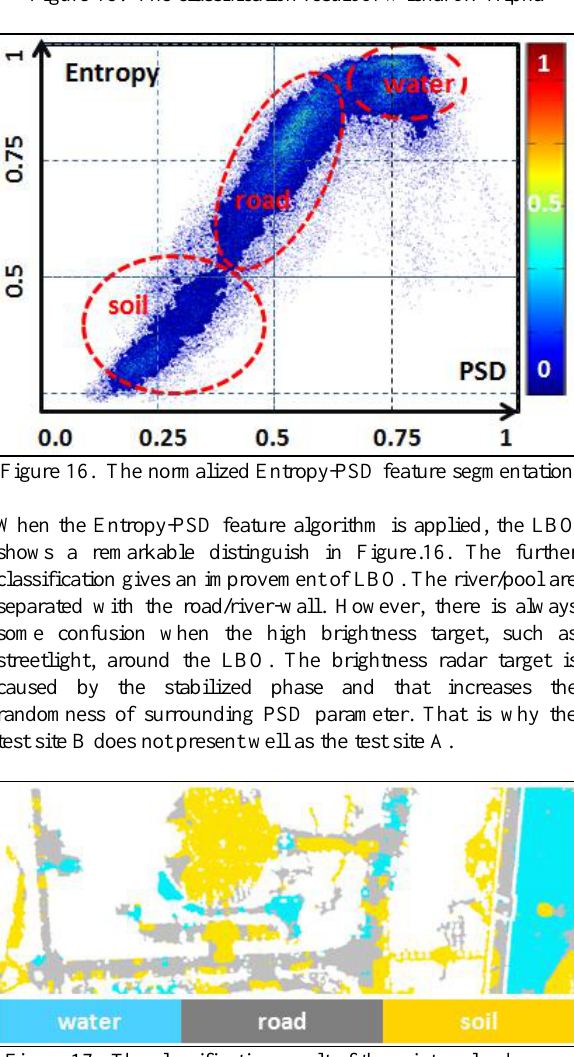
Figure 15. The classification result of Wishart-H-Alpha